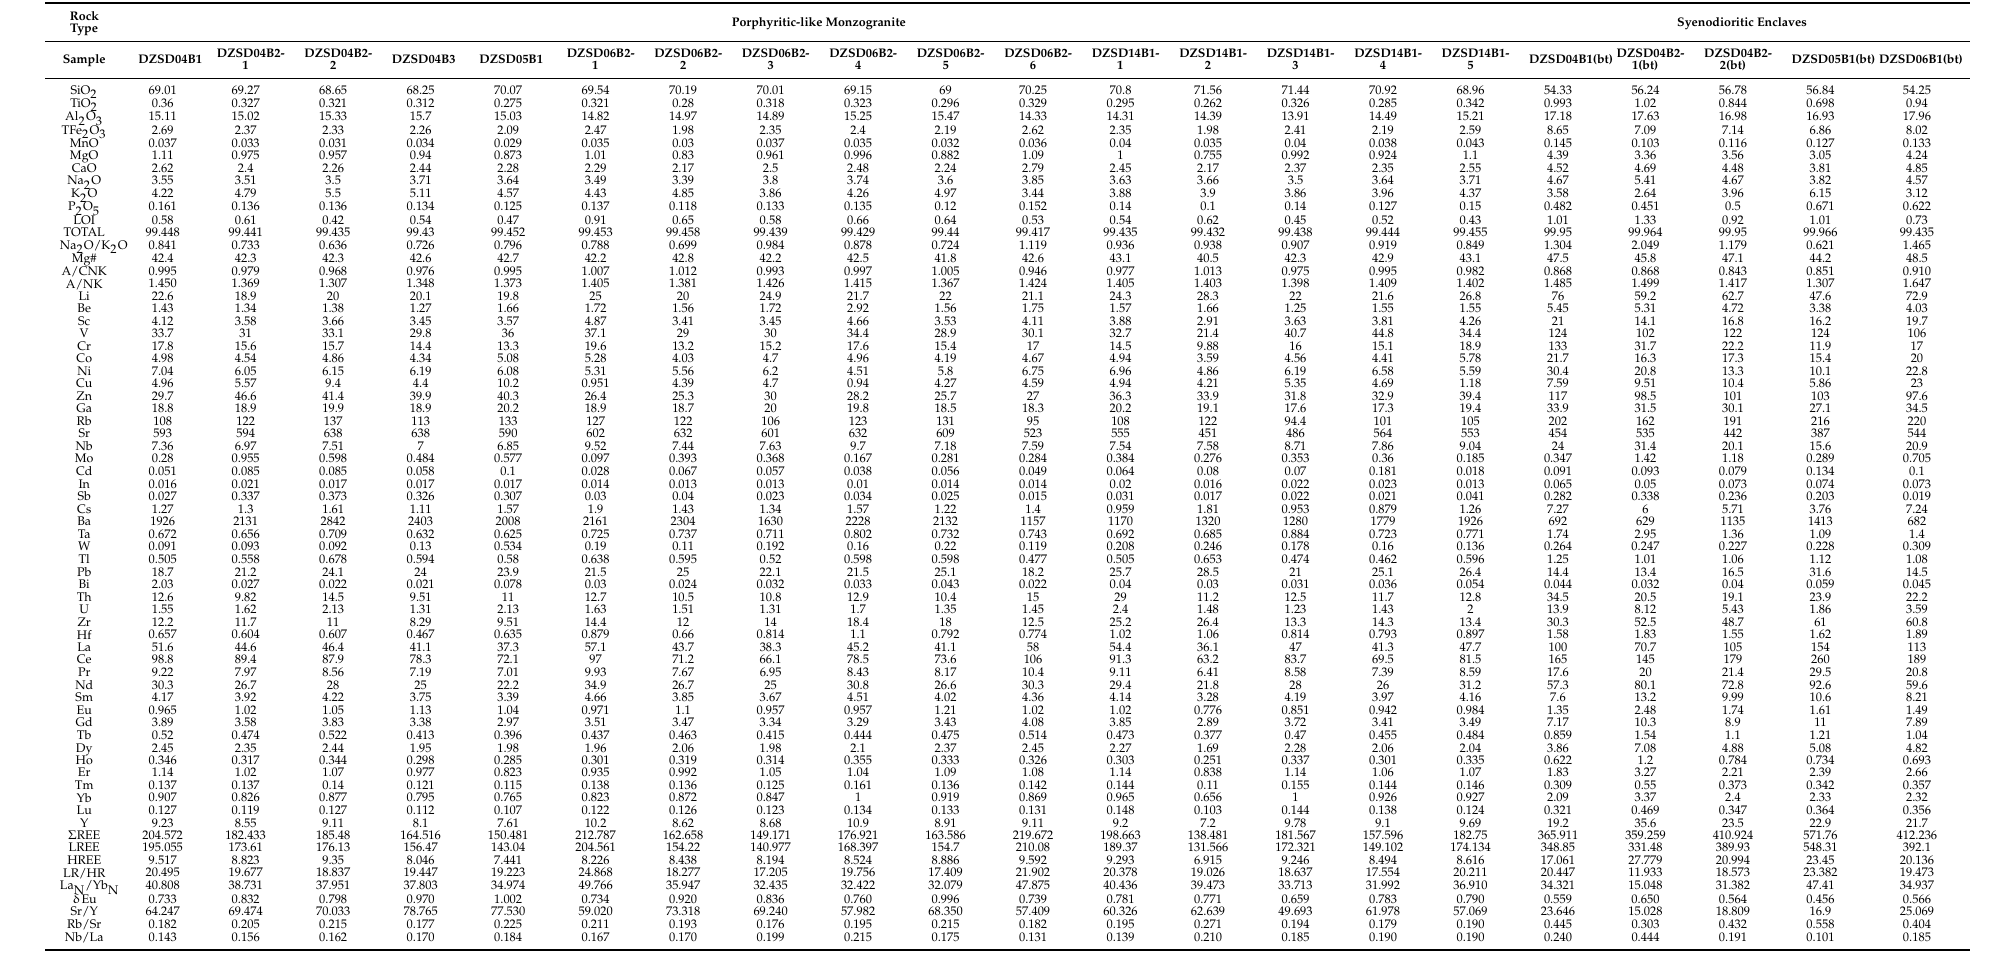
Table A1. Major (wt.%) and trace element (ppm) compositions for dark enclaves and granitoids of the Dazeshan